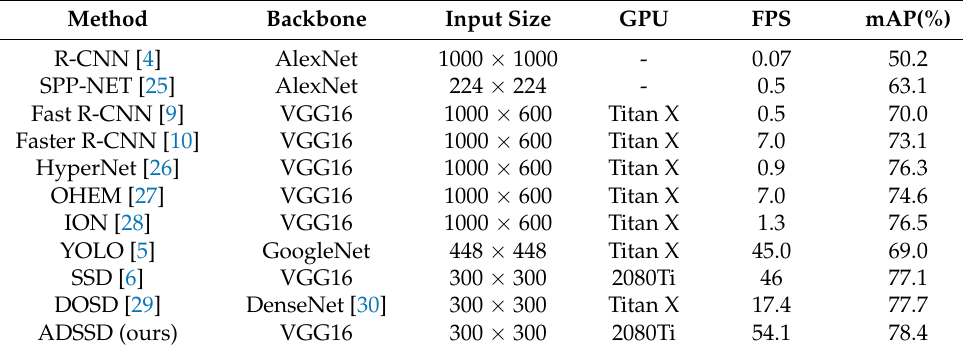
Table 4. Performance in different object-detection